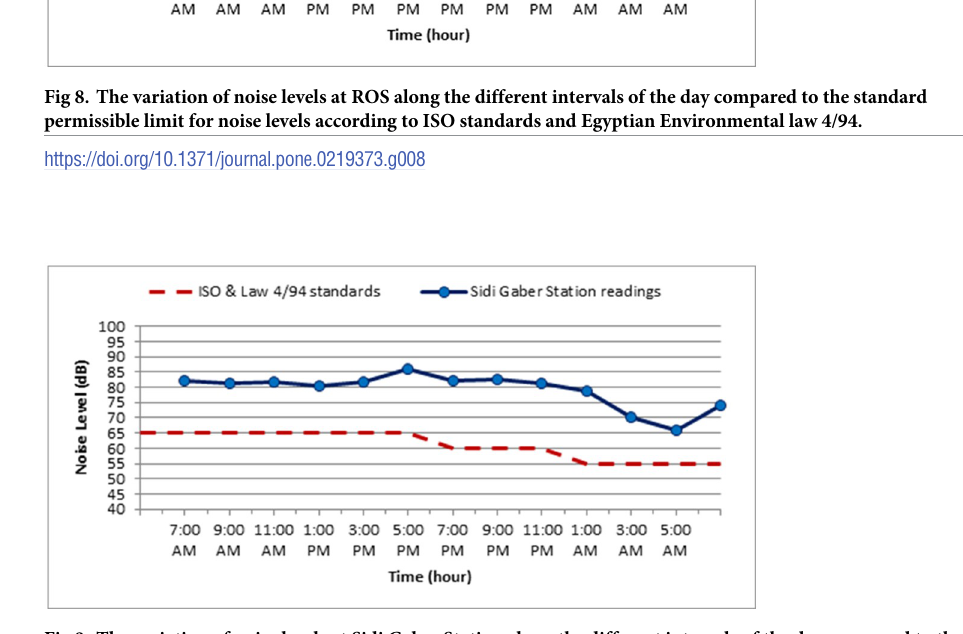
Fig 9. The variation of noise levels at Sidi Gaber Station along the different intervals of the day compared to the standard permissible limit for noise levels according to ISO standards and Egyptian Environmental law 4/94.